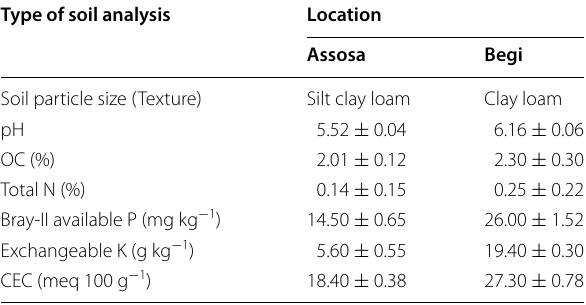
Table 1 Some selected physical and chemical properties of soils for the experimental sites before planting Type of soil